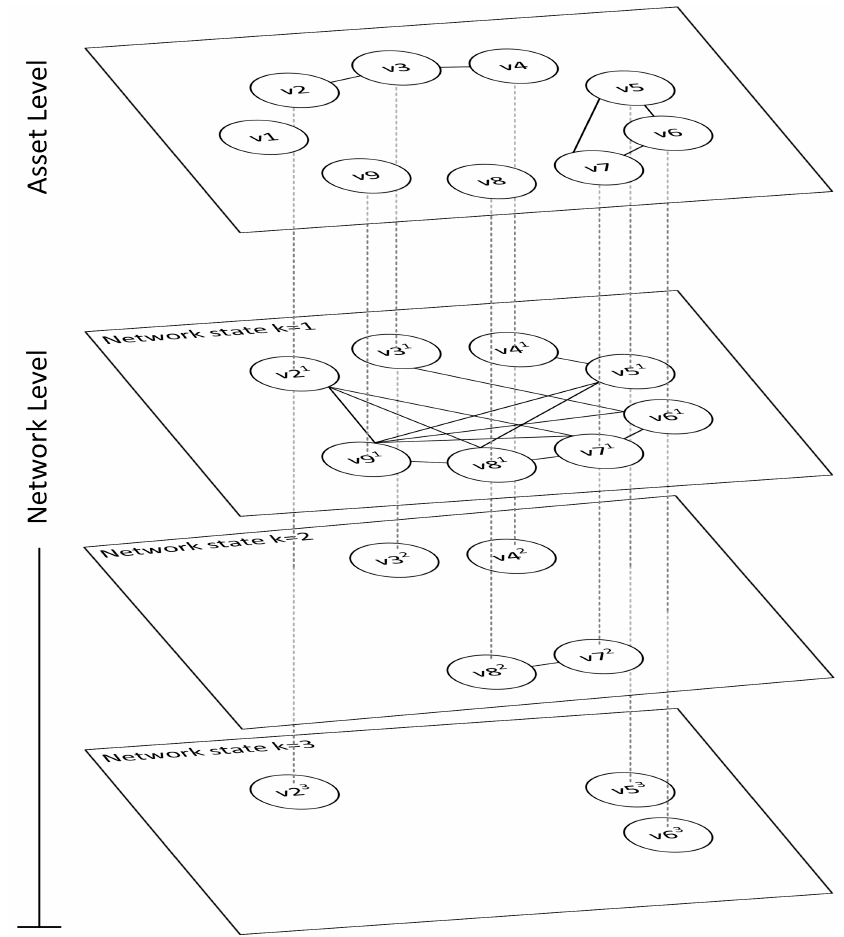
Figure 1. Bi-level graph theory system model.